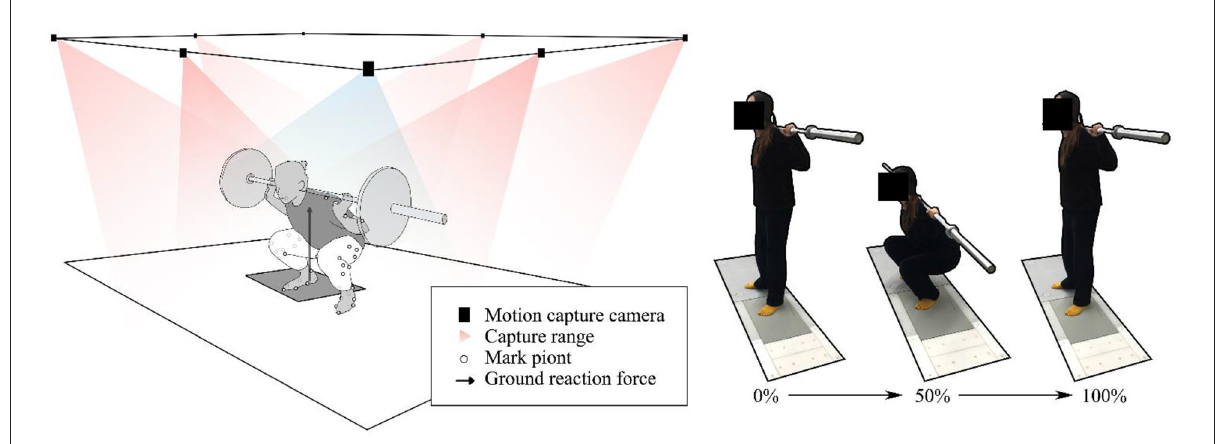
FIGURE1 Experimental process, (left) participant motion capture setup, and (right) squat